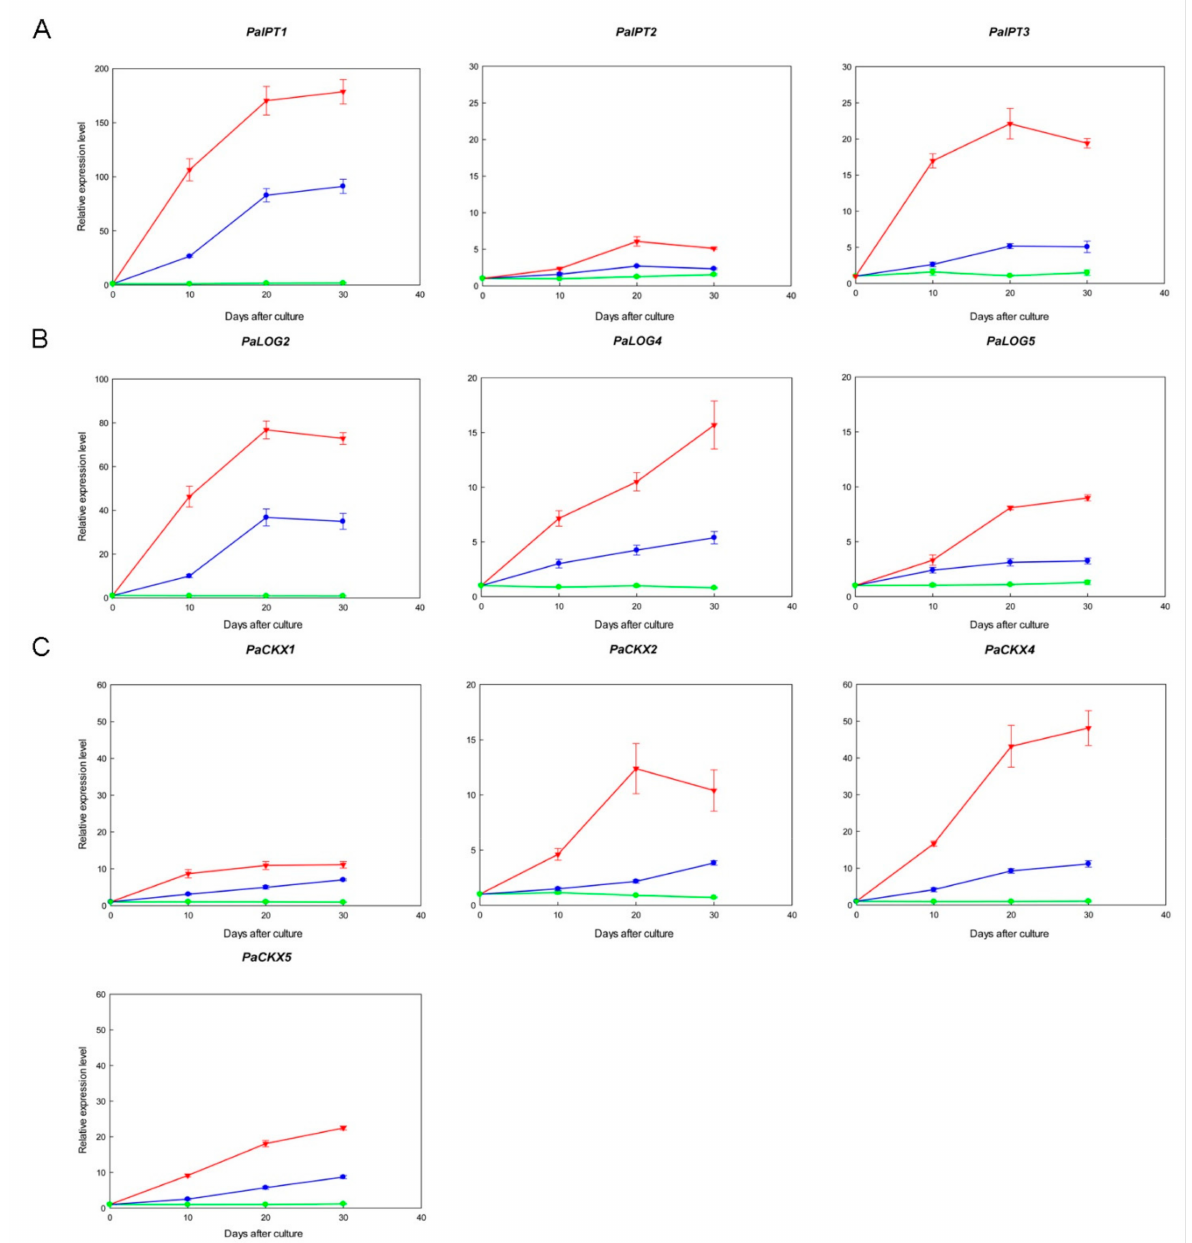
Figure 4. Transcript levels of cytokinins metabolic genes in micropropagated shoots inoculated at 0 (control, green), 0.45 (blue), or 4.54 (red) µ M TDZ for 30 days. ( A ) PaIPTs ; ( B ) PaLOGs ; ( C ) PaCKXs . Fold changes (relative expression levels) are normalized to the corresponding controls (the respective non-treated micropropagated shoot at 0 day, 10 days, 20 days, or 30 days after culture). Data are the mean of three biological replicates and error bars represent ± standard